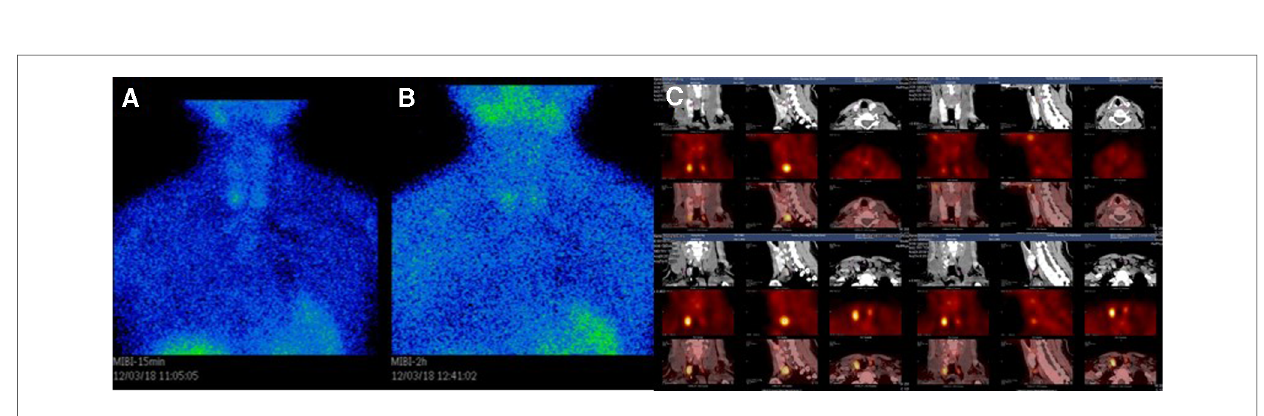
FIGURE 3 ( A ) 99mTc-MIBI dual-phase planar imaging. The early phase (15 min) planar images showed MIBI uptake in the inferior pole of the right thyroid lobe. ( B ) The delayed phase (2 h) planar images showed MIBI uptake in the inferior and upper pole of the bilateral thyroid lobes. ( C ) 99mTc-MIBI SPECT/CT imaging showing small soft-tissue masses with MIBI uptake in the back of the inferior Poles of both bilateral thyroid